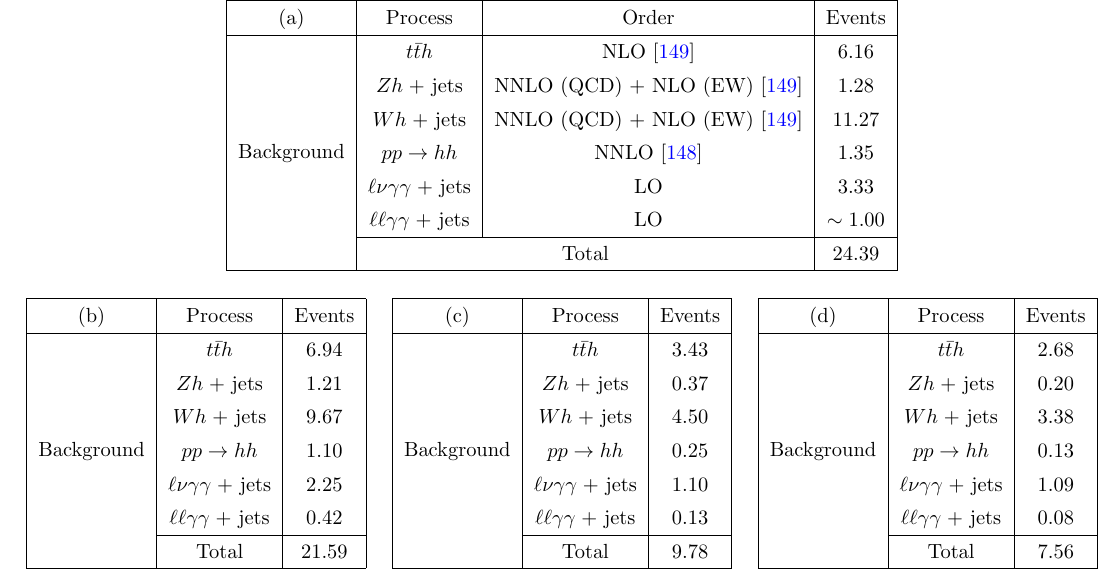
Table 13 . Respective background yields for the (cid:13)(cid:13) 1 ‘ 2 j + =E T channel after the BDT analyses optimised for m H = ( a ) 400 GeV, ( b ) 600 GeV, ( c ) 800 GeV and ( d ) 1 TeV. The tables also list the perturbative order at which the cross-sections are